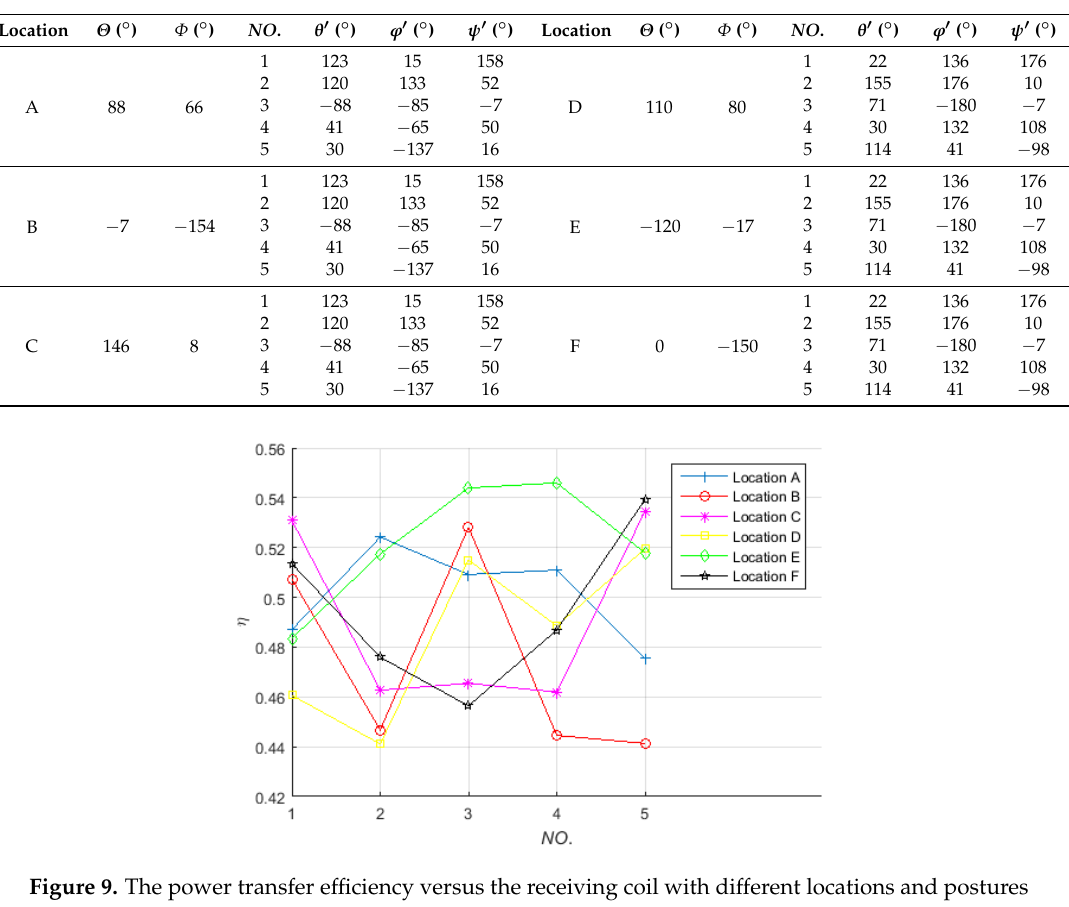
Table 3. Random sampling values of parameter set ( Θ , Φ , θ ′ , φ ′ , ψ ′ ).